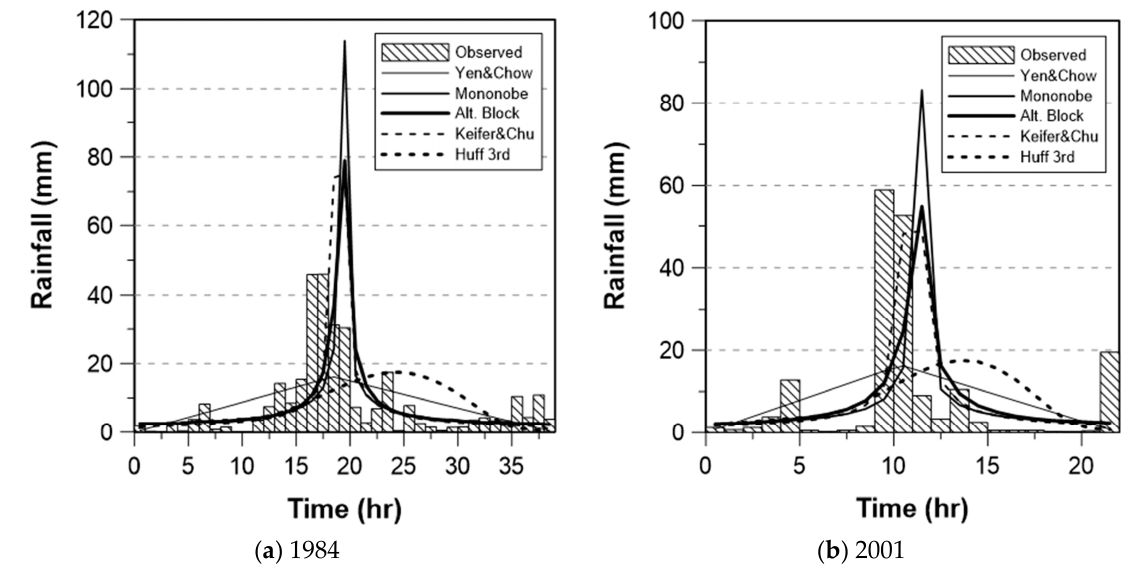
Figure 2. Comparison of the rainfall temporal distribution models and observed annual maximum rainfall events in 1981 ( a ) and in 2004 ( b ) (Case 1).